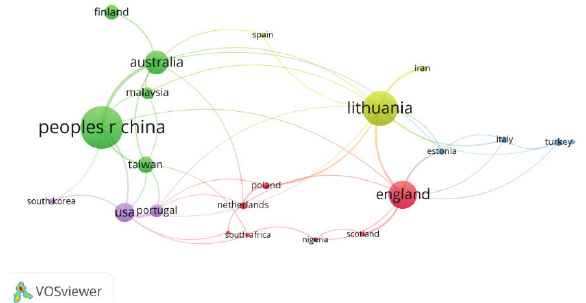
Figure 8. Country/region co-authorship network of